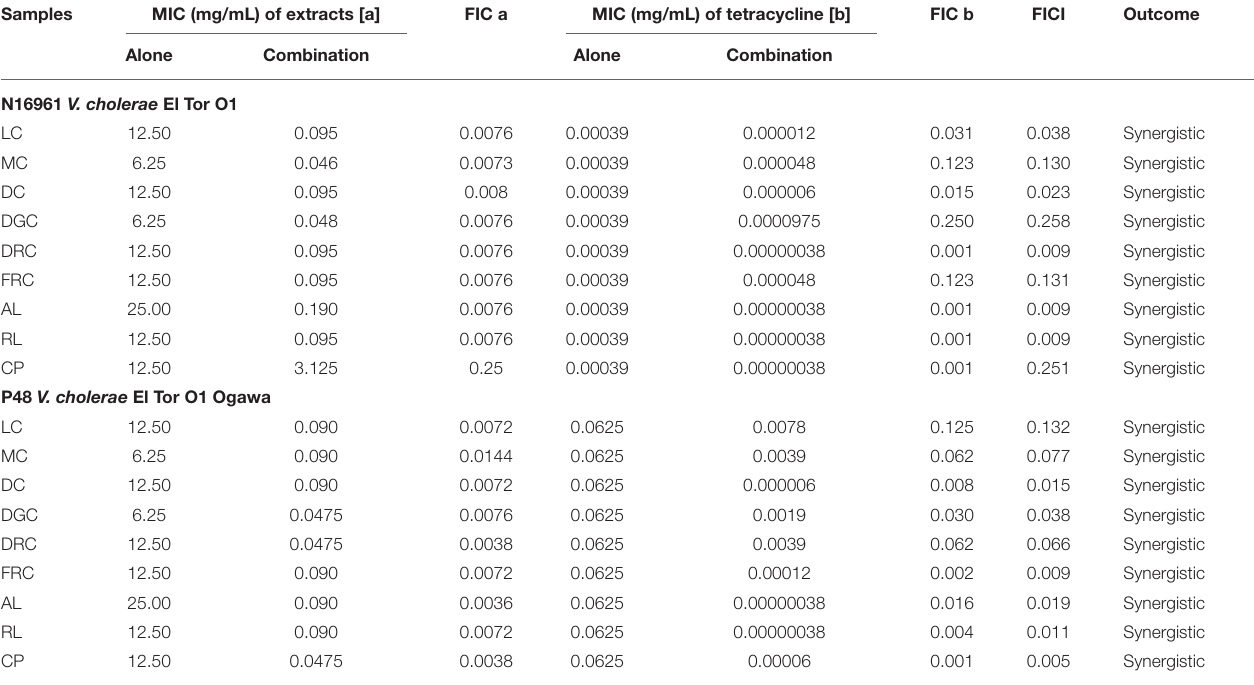
TABLE 4 | Synergistic effect of coffee beans and coffee by-products in combination with tetracycline against standard and multidrug-resistant V. cholerae . Samples